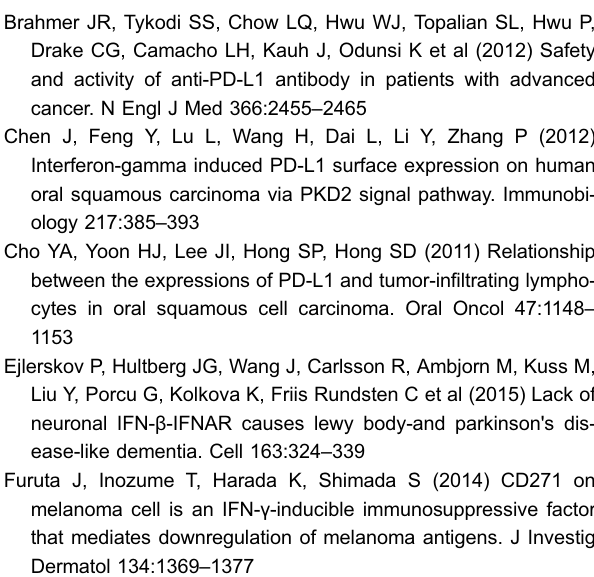
Figure 2. Upregulation of PD-L1 in tumor cells was depen- dent on IFNAR1 signaling . (A – C) IRF7 and ISG15 mRNA level in B16F10 cells were determined, which were treated for 24 h with co-culture supernatant from B16F10 cells and bone marrow (A), or lymph nodes derived cells (B) or splenocytes (C), respectively. (D) After treated with the similar above supernatant in (A – C) for 15 min, the phosphorylation of STAT1 and STAT3 were determined. (E – G) B16F10 cells were co- cultured with splenocytes in three different co-culture systems with or without the 20 µg/mL anti-IFNAR1 antibody. PD-L1 expression was measured by fl ow cytometry in direct co-culture system (E), transwell co-culture system (F), and supernatant transfer system (G). (H) Heat map demonstrated relative abundance of cytokines in different cell co-culture supernatant. (I) Schematic model of PD-L1 induction in tumor cells by the interaction between immune and tumor cells. Immune cells directly contact tumor cells ( ➀ Direct interaction). Then the secretome is actively secreted into the supernatant ( ➁ Secre- tion). Interferons, one type of factors in the secretome, bind to IFN receptors ( ➂ Interferons) and further upregulate endoge- nous PD-L1 expression in both contacted tumor cells and uncontacted tumor cells ( ➃ PD-L1